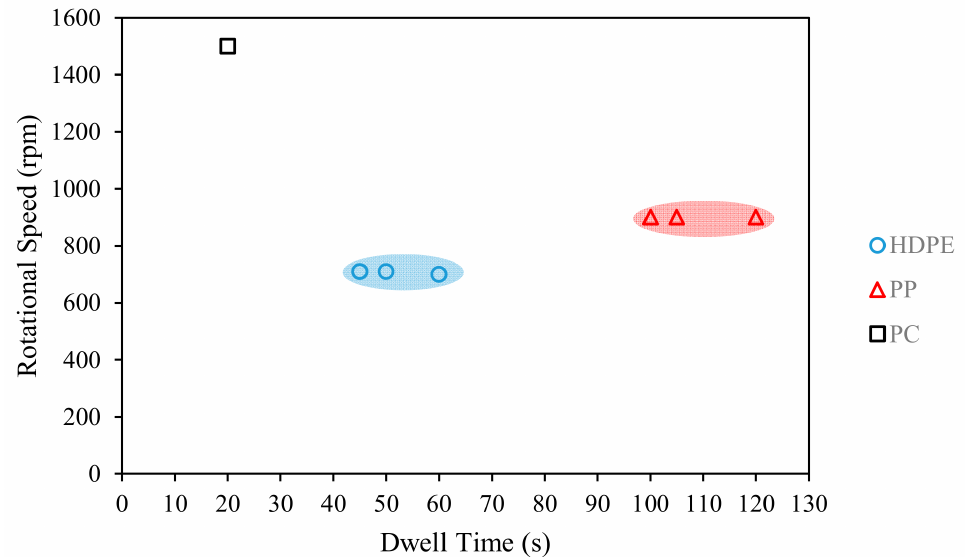
Figure 5. Optimal dwell times and rotational speeds for maximum joint strength of FSSW of thermoplastic